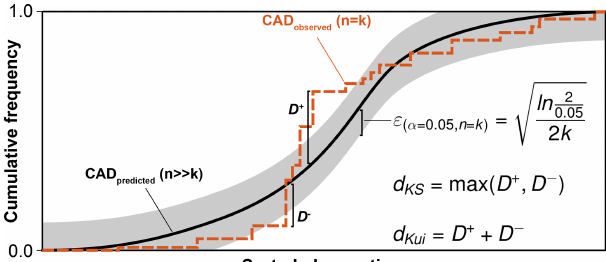
Figure 3. Example of metrics to compare two cumulative distri- butions drawn from different sample sizes. Here, an observed cu- mulative age distribution (CAD) for n = k (stepwise dashed orange line) is compared to a predicted CAD drawn for n (cid:29) k (solid black line). The Kolmogorov–Smirnov statistic d KS equals the maximum absolute vertical distance between distributions in the observations– frequency space. The Kuiper statistic d Kui equals the sum of both positive and negative maxima. For α = 0 . 05 (i.e., 95% confidence) and n = k , a Dvoretzky–Kiefer–Wolfowitz confidence region can be calculated (gray shading). In this example, observed and predicted distributions are drawn from two statistically different populations at the 95% confidence level because the orange curve exceeds the gray